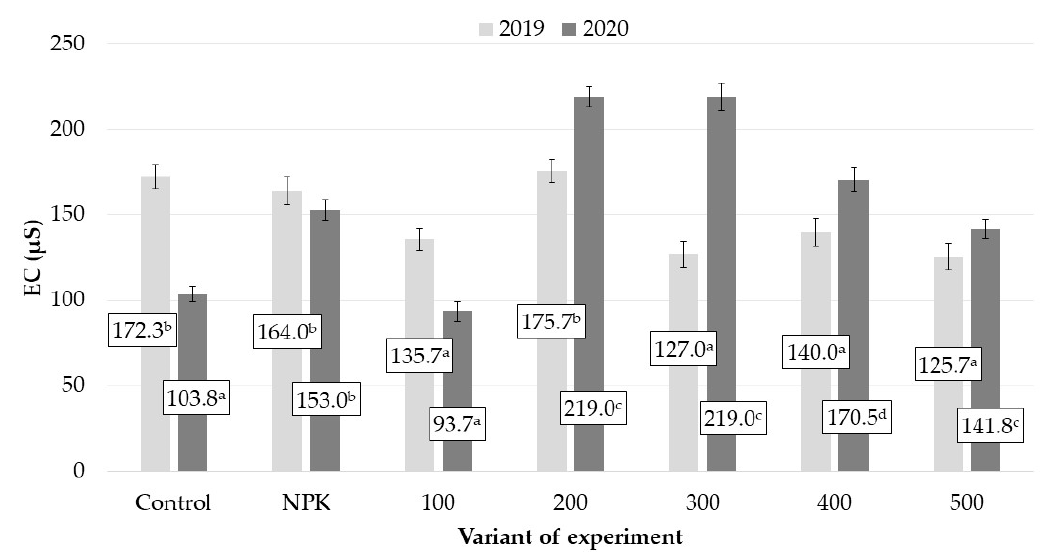
Figure 2. Changes in the salinity of the podzolic soil in the 0-5 cm layer after application of biomass combustion ashes (mean ± SD). Identical superscripts indicate that there are no significant ( p > 0.05) differences between the experimental variants, as shown by the Tukey HSD post hoc test.